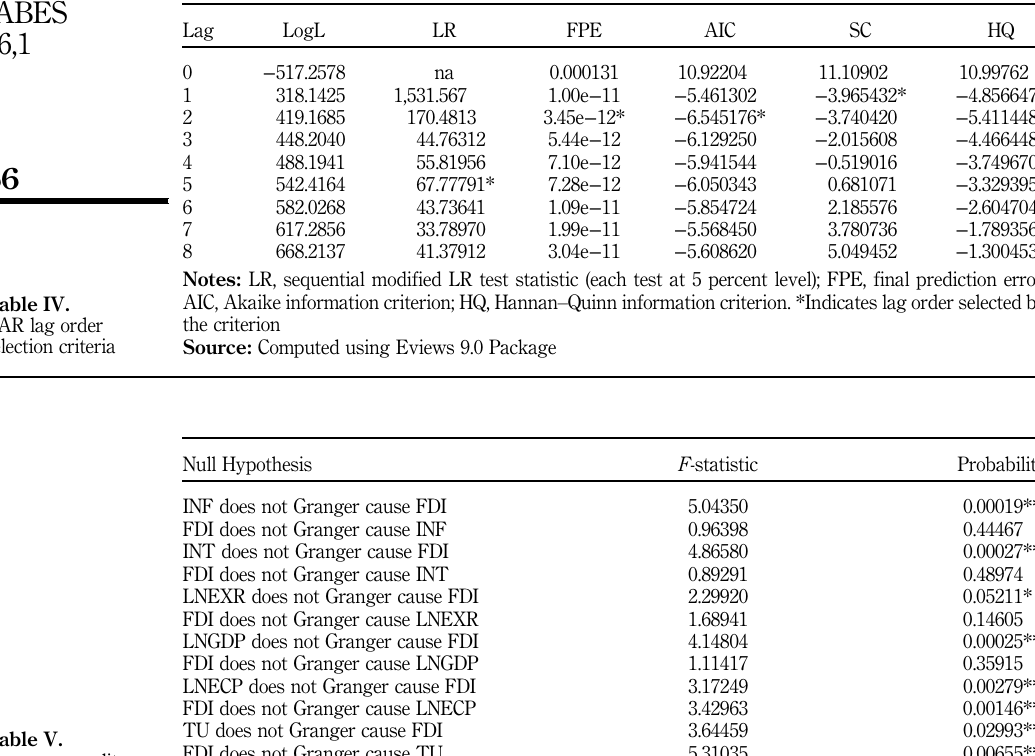
Table V. Granger causality between FDI and its